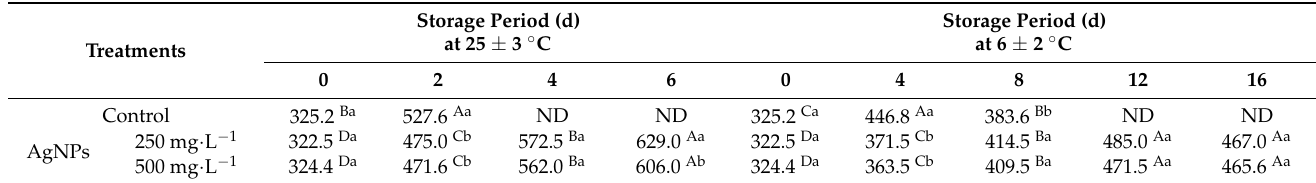
Table 6. Anthocyanin content (mg · kg − 1 ) in strawberry fruit during